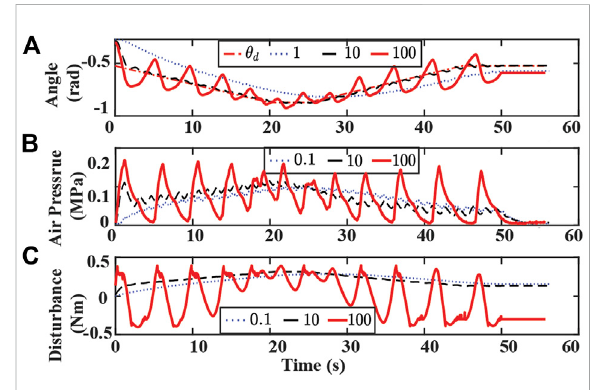
FIGURE 12 Experiment results of tracking bending angle with obstacle and changing λ . (A) Bending angle tracking results where θ is the original desired (dash-dotted red), and λ are set to 0.1 (dotted blue), 10 (dashed black), 100 (solid red), respectively. (B) Air pressure measurements of chamber 1. (C) Lumped disturbance